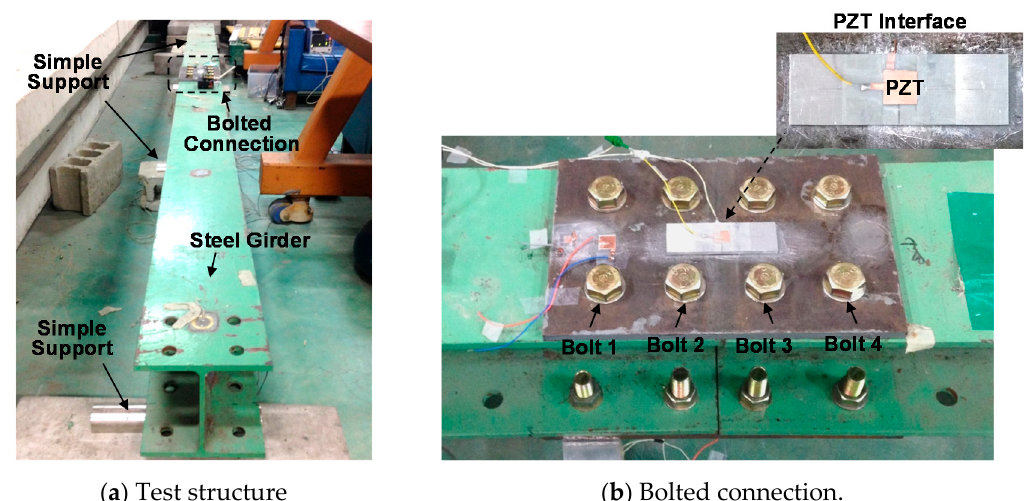
Figure 10. Experimental setup of bolted girder connection.